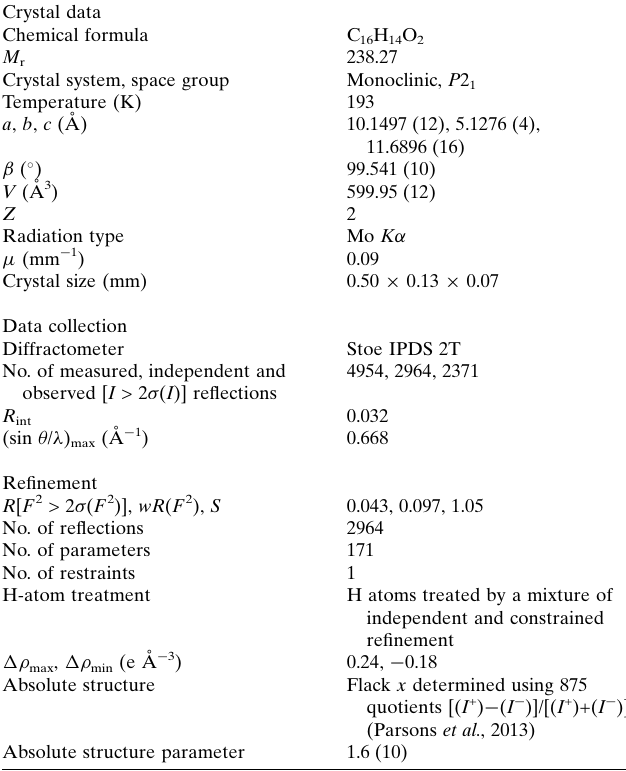
Table 2 Experimental details.